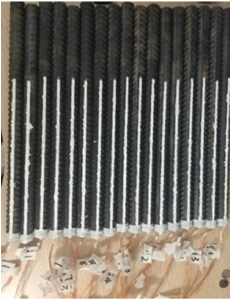
Figure 6. Steel reinforcement: Waterproofing treatment of steel bars. Adapted with permission from [29].